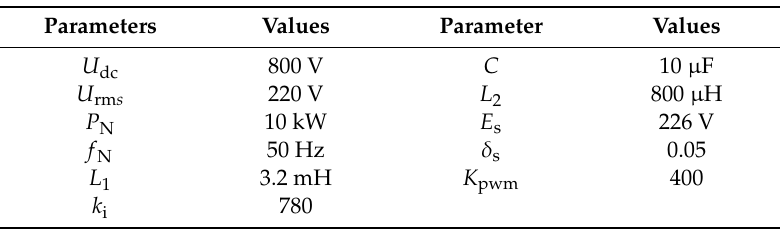
Table 1. VSG control system parameters.